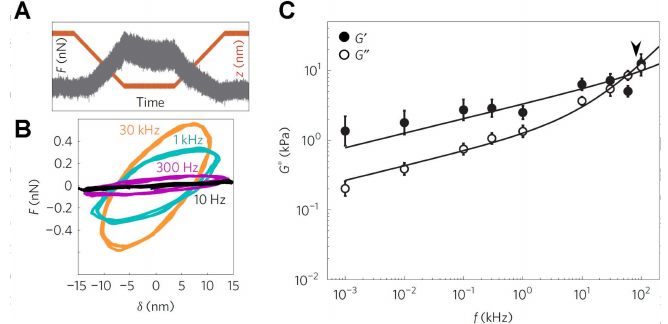
Figure 3. Measurement of the visco-elasticity of living cells over a broad range of application frequencies. ( A ) Typical force–time trace for the case with a 1 kHz oscillation obtained on a 3T3 fibroblast cell. Upon attaining an indentation of 250 nm, there is a small reduction in force, from a maximum of 0.5 nN, together with the superimposed oscillation; ( B ) The force–indentation cycles determined from the contact region of force curves exhibit significant differences at different oscillation frequencies, notably in the slope and degree of hysteresis in the cycle; ( C ) Frequency dependence of the storage modulus, G (cid:48) , and loss modulus, G (cid:48)(cid:48) , from the 3T3 cells. The transition frequency, separating the two regimes, is depicted by the arrowhead. This image is adapted from Rigato et al. published by Nature (2017)